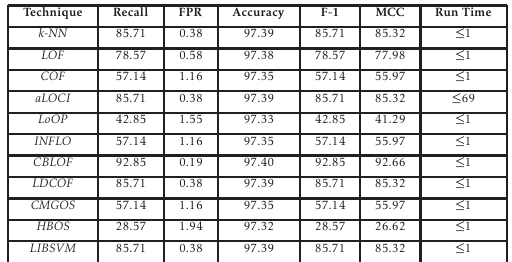
Table 4. Performance of Anomaly Detection Techniques on Real SCADA Dataset (WTP: Water Treatment Plant) Technique